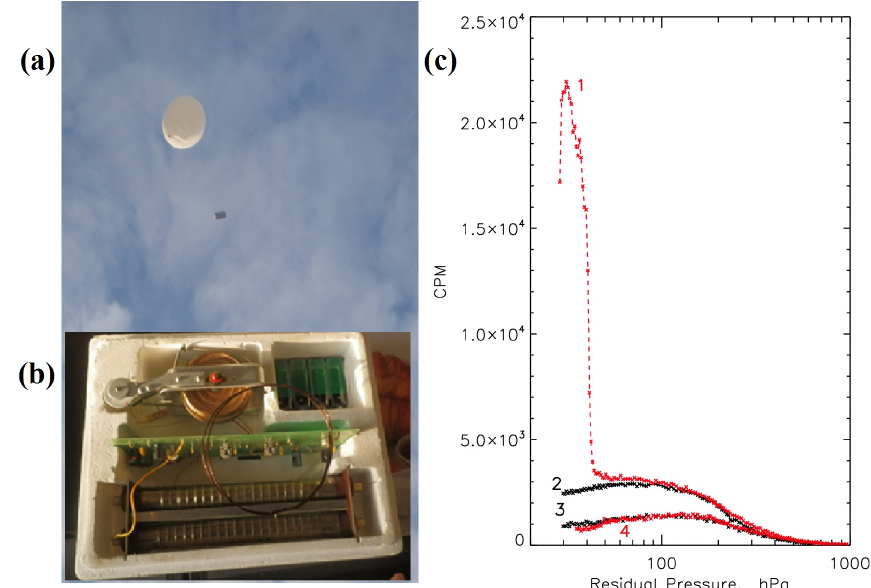
Figure 1. A balloon in flight (a) and a radiosonde layout (b) showing two Geiger–Müller tubes (a top counter referred to as a single tube and telescope, arranged as a telescope detecting particles passing through both tubes and the filter between). Panel (c) shows the results (CPM, count rates per minute, of two Geiger–Müller tubes) of observations in the Moscow region on 14 December 2009 (curves 1 and 4) and on 11 December 2009 (curves 2 and 3). Curves 1 and 2 are the single Geiger–Müller tube count rates, which are sensitive to X-rays. The telescope (sensitive to charged particles) count rate (curves 3 and 4) is multiplied by 3.